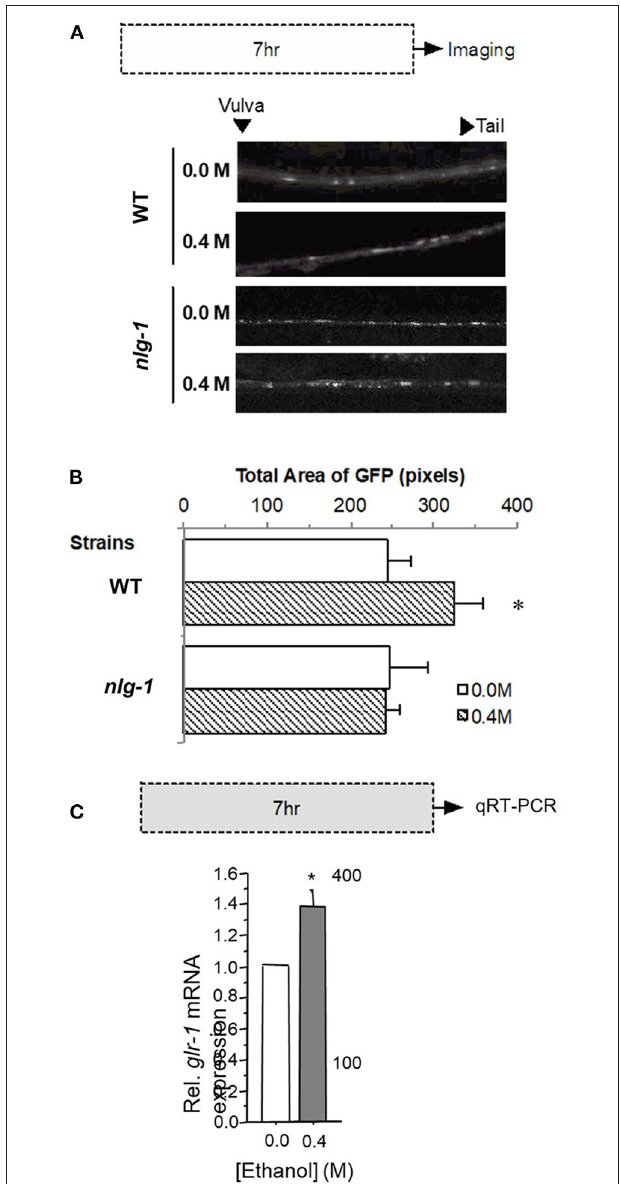
FIGURE 5 | Expression of GLR-1 receptors in either a wild-type or nlg-1 mutant worm background after 7h ethanol exposure. (A) Protocol for 0.4M ethanol exposure (gray rectangle) followed by confocal imaging and sample images captured from GLR-1::GFP worms that are either WT (for nlg-1 ) or carry a mutation in nlg-1 exposed to either 0.0 or 0.4M ethanol. (B) Mean Total GLR-1::GFP area ( ± SEM) for WT vs. nlg-1 mutant worms exposed to either 0.0 or 0.4M ethanol following 7-h exposure period. (C) glr-1 mRNA levels relative to actin ( act-1 ) expression ( ± SD) in control worms (0.0M ethanol) compared to treatment (0.4M ethanol) following 7-h exposure period. * = p <